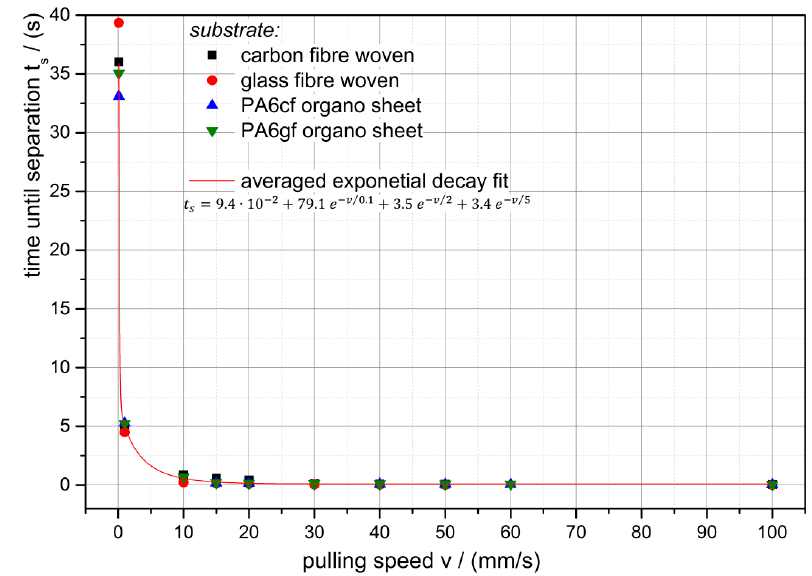
Figure 8. Pulling speed related time to separate the gripper stamp from the substrates; red line shows the trend of all measurement points.